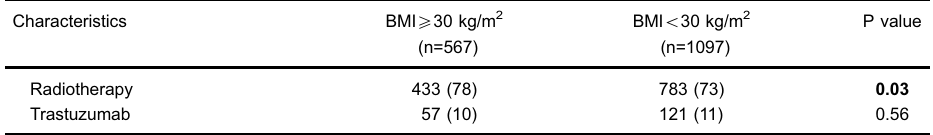
for categorical variables and Kuskall-Wallis test for continuous